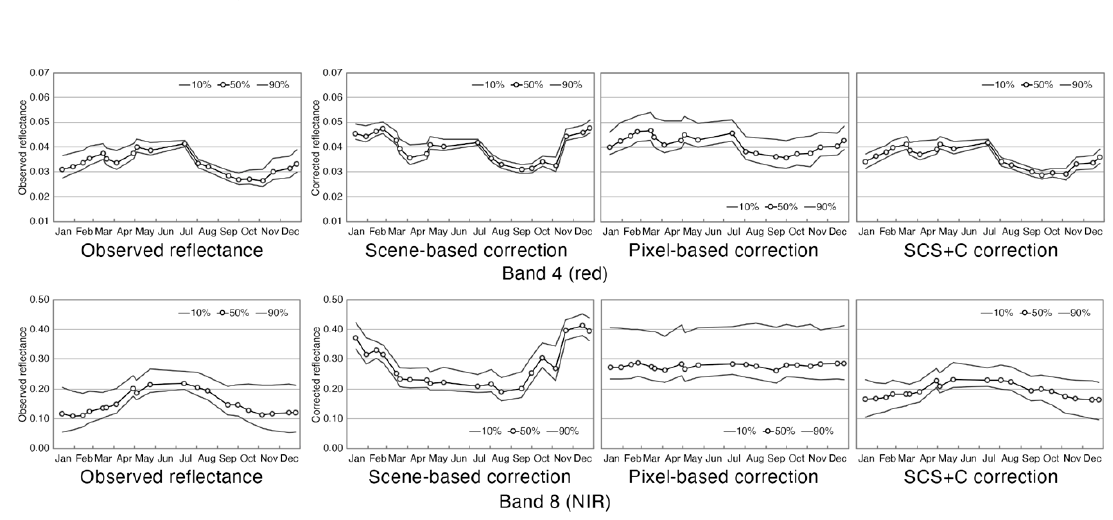
Figure 8. Time series of the 10th, 50th, and 90th percentiles of the seasonal reflectance for bands 4 and